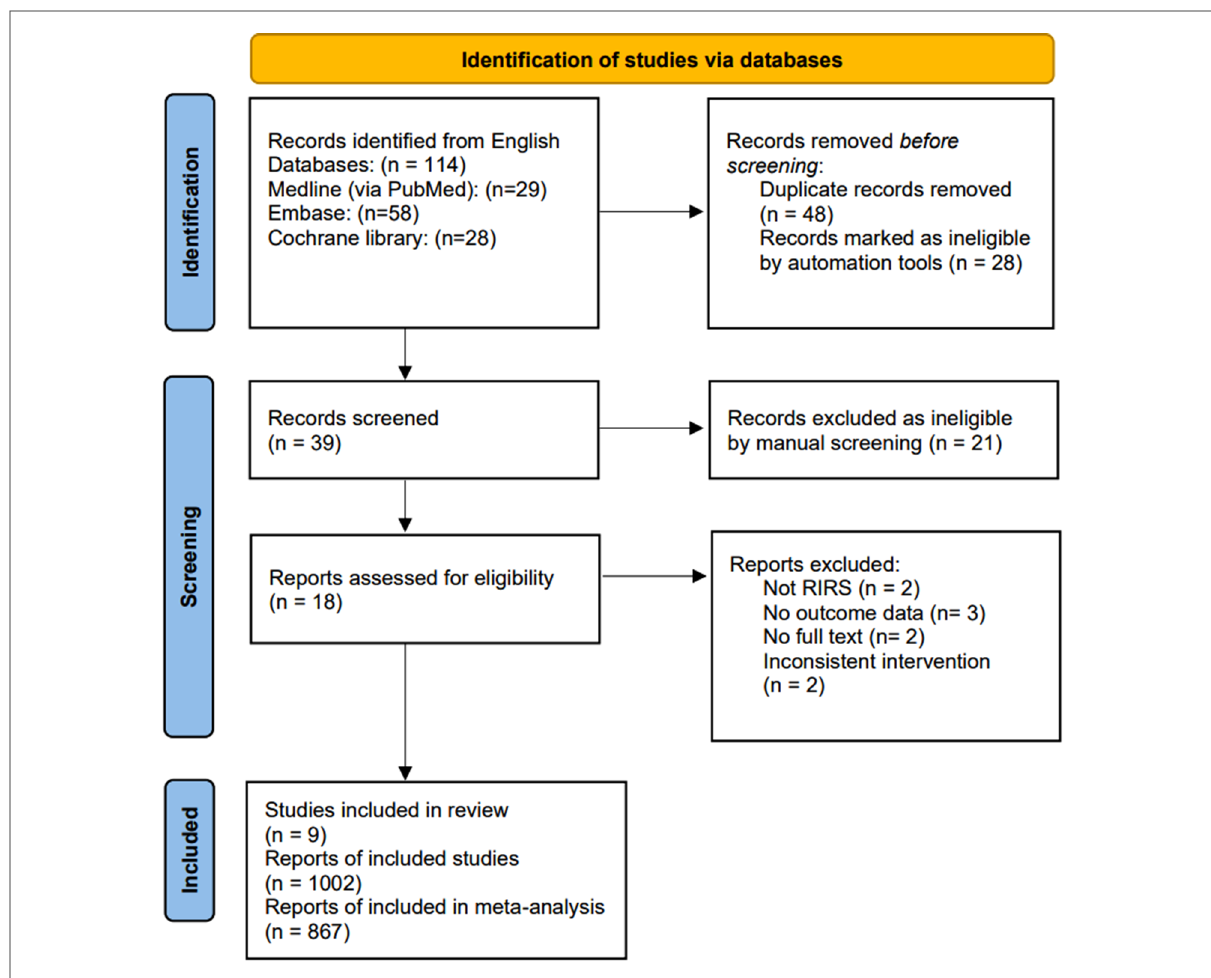
FIGURE 1 PRISMA 2020 fl ow diagram m for new systematic reviews which included searches of databases and registers only. *Consider, if feasible to do so, reporting the number of records identi fi ed from each database or register searched (rather than the total number across all databases/registers). **If automation tools were used, indicate how many records were excluded by a human and how many were excluded by automation